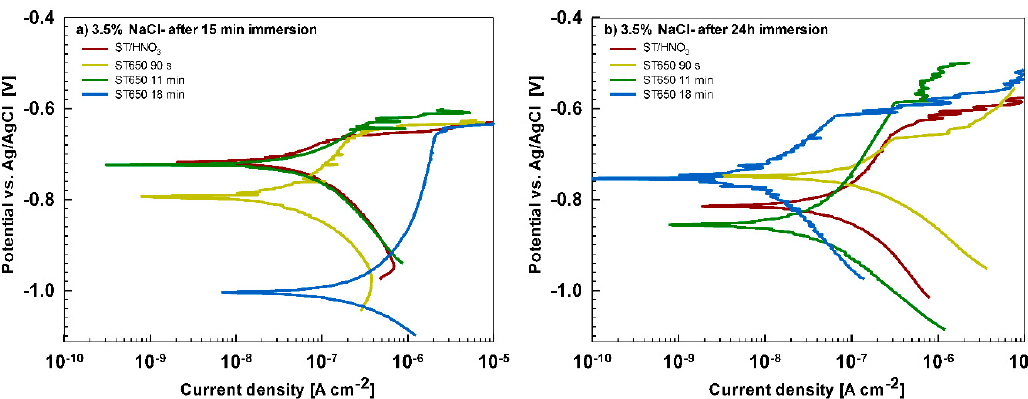
Figure 12. Potentiodynamic polarization curves in 3.5% NaCl after ( a ) 15 min immersion; ( b ) 24 h immersion for AA3003 samples coated with 10 % ST650 prepared for different conversion times: 90 s, 11 min and 18 min at room temperature. The samples were chemically pre-treated using ST/HNO 3 and the bare sample is given for comparison. The scan rate was 1 mV/s.